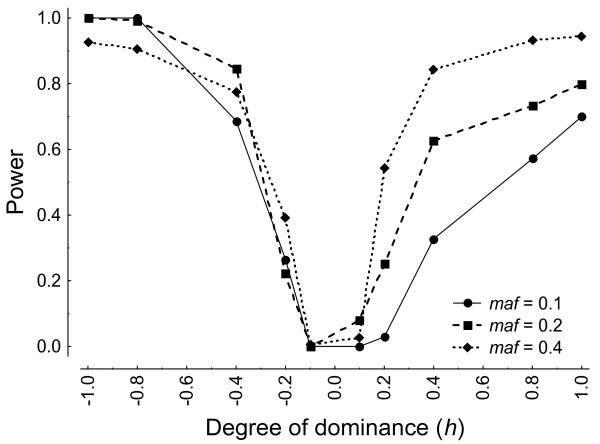
Plot of power versus h assuming HWE in the controls (P ≥ 0.05) for different frequencies of the mutant allele (maf).